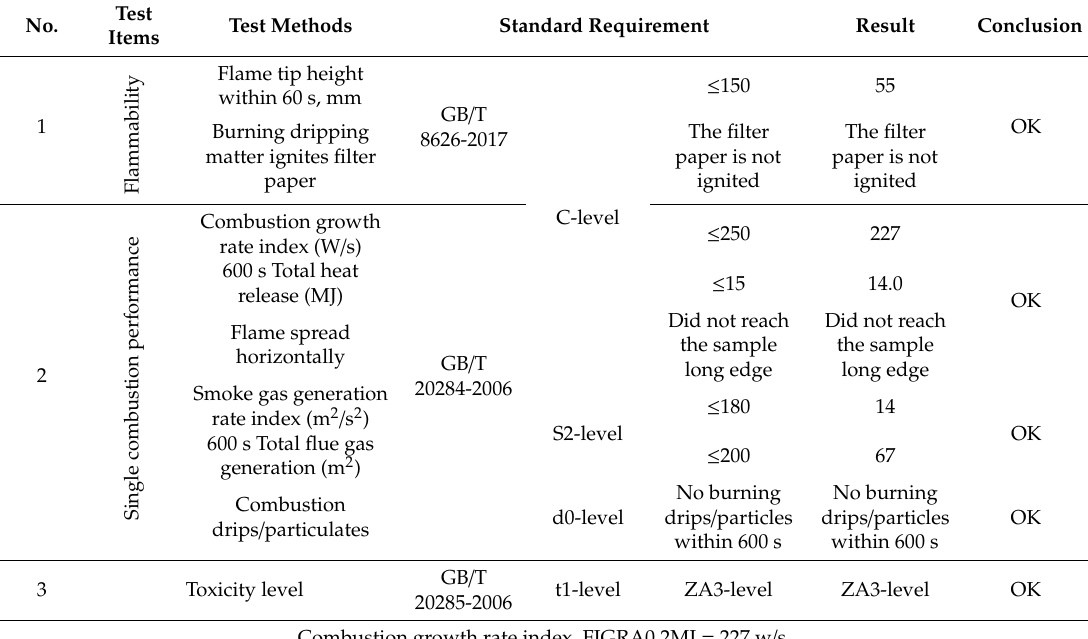
Table 8. Performance of joinery board decorated by flame-retardant impregnated thermosetting resins